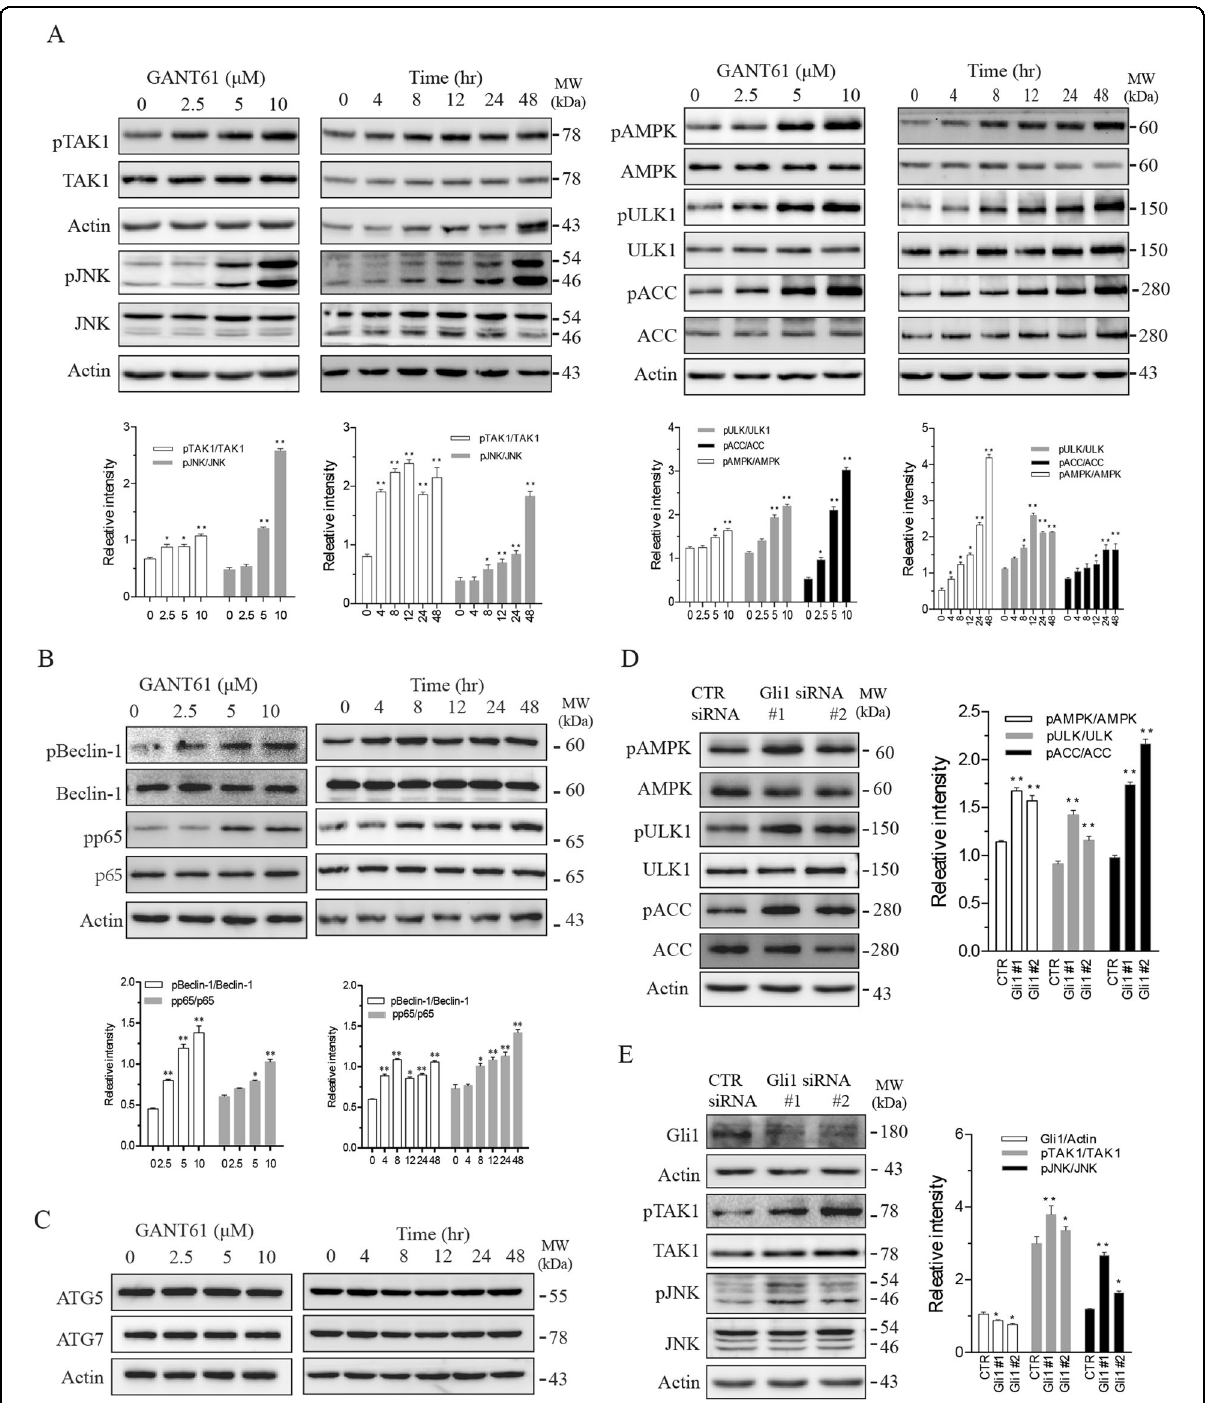
Fig. 2 Gli1 inhibition activates TAK1 and its downstream kinases. A – C SW1736 cells were treated with the indicated concentrations of GANT61 for 48 h or with 10 μ M GANT61 for the indicated lengths of time. D , E SW1736 cells were transfected with control or Gli1 siRNA and incubated for 48 h. Cell lysates were analyzed for protein phosphorylation and their total protein by western blot with the indicated antibodies. Protein band density was analyzed by using an NIH Image-J software. Data presented as the mean ± SD ( n = 3) relative to control are shown in bar graphs . *p < 0.05, **p < 0.01, compared to the untreated control or the scrambled siRNA